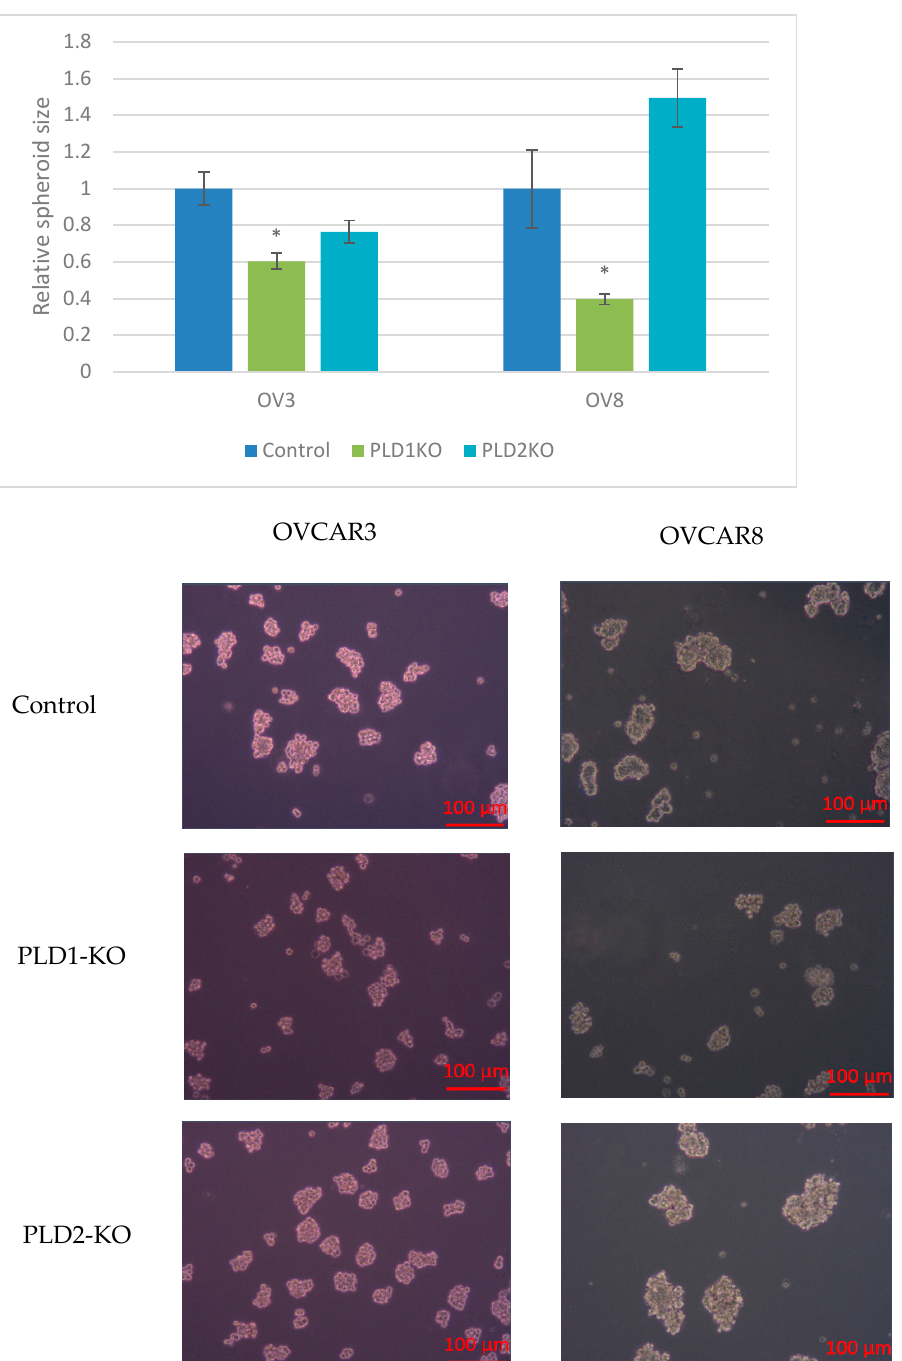
Figure 7. PLD1-KO cells generates significantly smaller spheroids. The perimeters of PLD1-KO spheroids were significantly smaller than those of controls in both cell lines ( p < 0.05). Microscopy images display differences between control and KO cells (* p < 0.05).